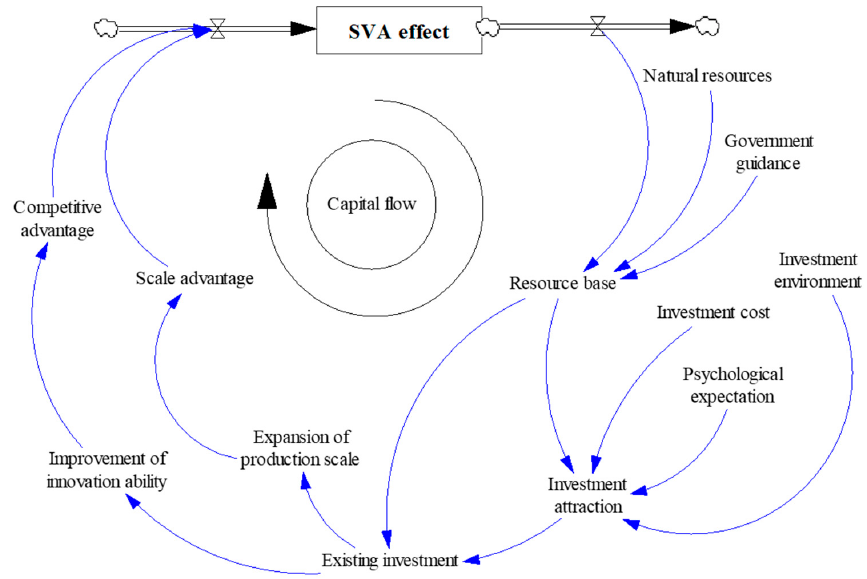
Figure 4. Capital flow causality. Arrows indicate causality; Clockwise arrow indicates positive feed-